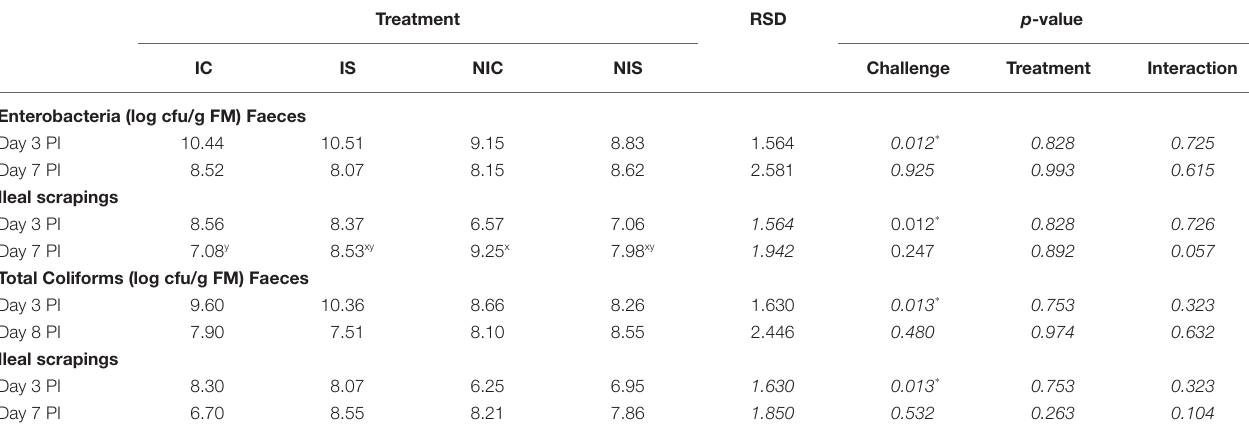
TABLE 3 | Effects of experimental treatments on enterobacteria and coliform counts in faecal samples and ileal scrapings. Treatment RSD p -value IC IS NIC NIS Challenge Treatment